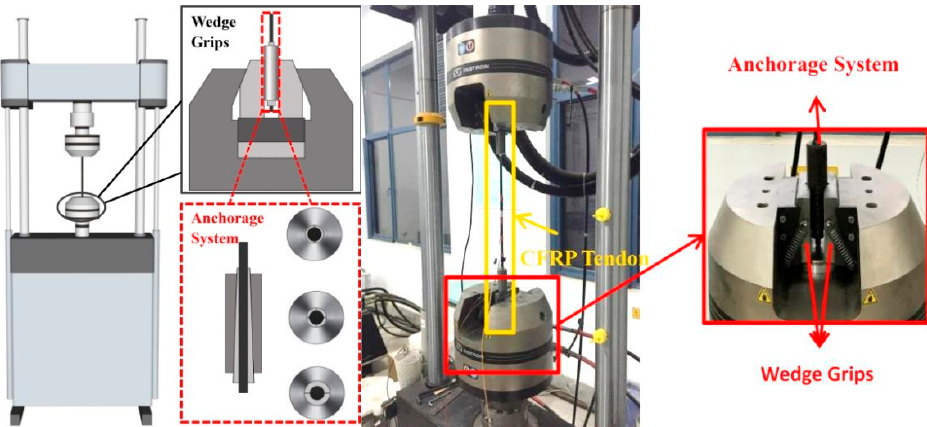
Table 1. Mechanical Properties of CFRP tendons measured from experiments.